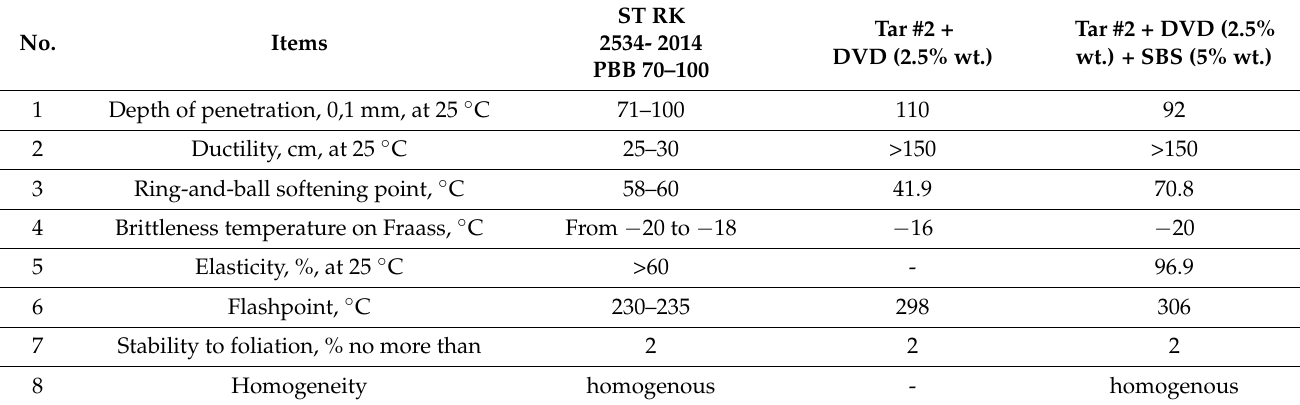
Table 4. The results of the test of modified